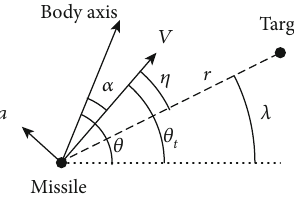
Figure 4: Engagement geometry of missile and a stationary